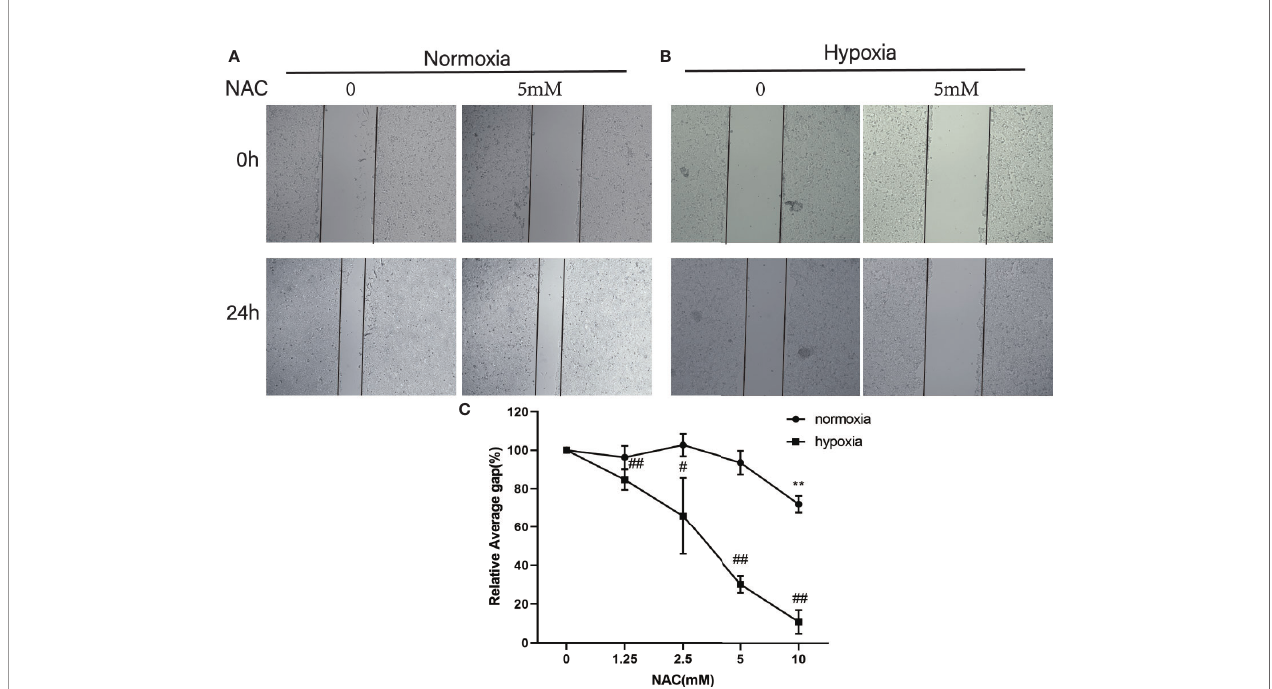
FIGURE 2 | NAC inhibits colorectal cancer cell migration under hypoxia condition. Wound-healing assay for evaluating the migration ability of HCT-116 cells under normoxia (A) and hypoxia condition (B) ; cells were photographed at 0 and 24 h under 50× magni fi cation. (C) The relative scratch area was measured by Image J (normoxia group, ** P < 0.01; hypoxia group, # P < 0.05, ## P < 0.01, ### P < 0.001).